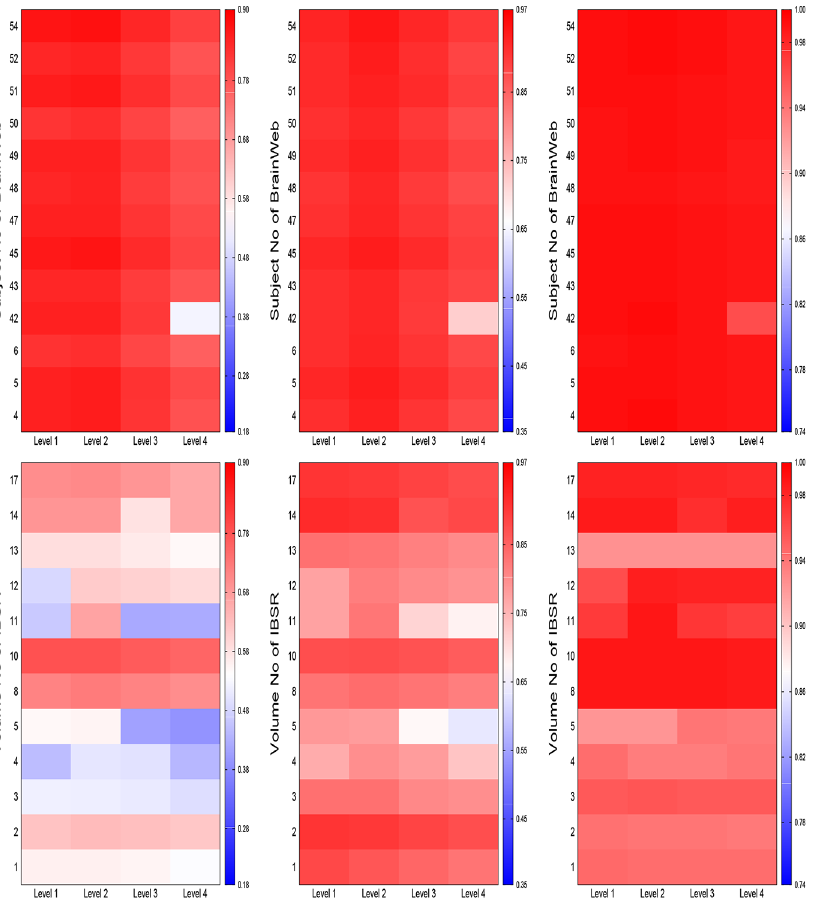
Fig 8. Heat maps for comparative performance analysis of different decomposition levels of wavelet analysis (from left to right: Jaccard index, sensitivity, and specificity).